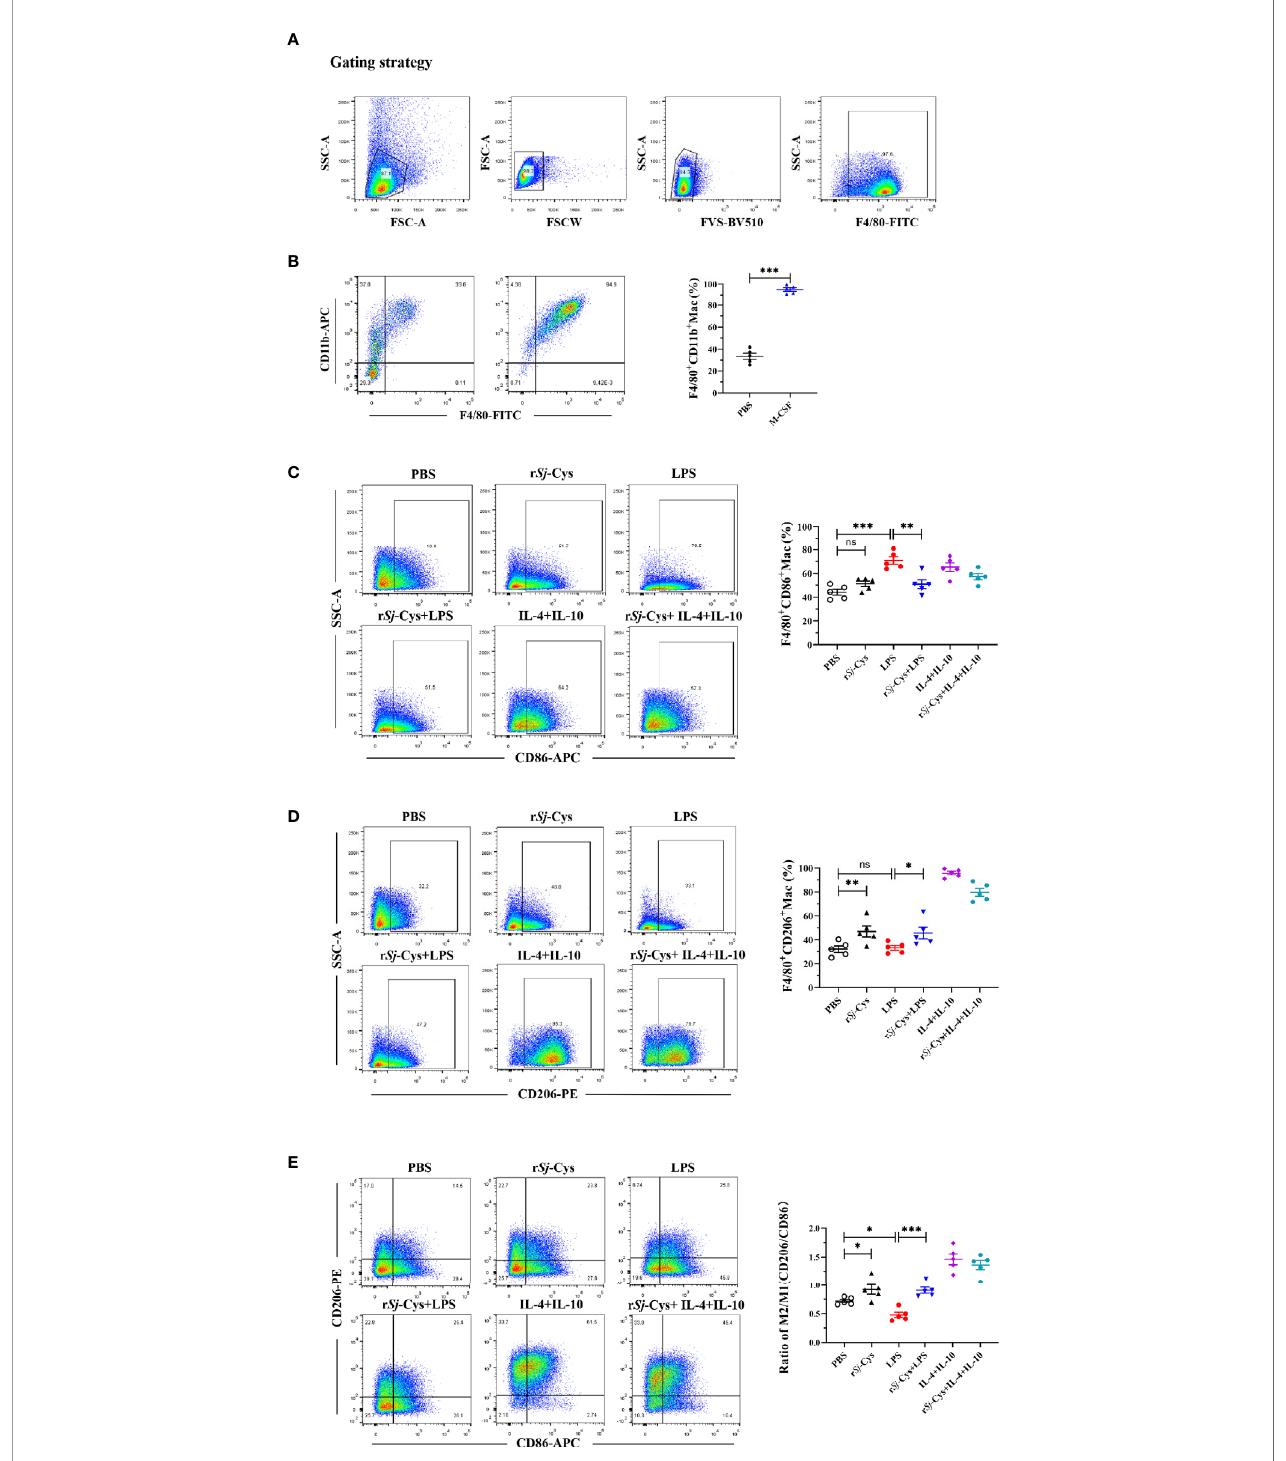
FIGURE 2 | r Sj -Cys induced M2 macrophage polarization and reduced LPS-induced M1 macrophages phenotype in vitro . (A) The fl ow cytometry experiments were repeated by adding live/dead cell staining, and re-gated to differentiate dead cells, adhere cells and to block Fc. (B) BMDMs were obtained by incubating mouse bone marrow cells (adherent) with M-CSF for 7 days. The mature BMDMs were de fi ned as CD11b + F4/80 + subpopulations using FACS. (C – E) BMDMs were incubated with r Sj -Cys (2 ug/ml), LPS (100 ng/ml), IL-4 (10 ng/ml) + IL-10 (10 ng/ml), r Sj -Cys + LPS, r Sj -Cys + IL-4 + IL-10, or PBS, respectively, for 24 h. The M1 (CD86) and M2 (CD206) markers were detected using FACS. n = 5. Data are expressed as mean ± SEM, ns, not signi fi cant, * P < 0.05, ** P < 0.01, *** P < 0.001, **** P <